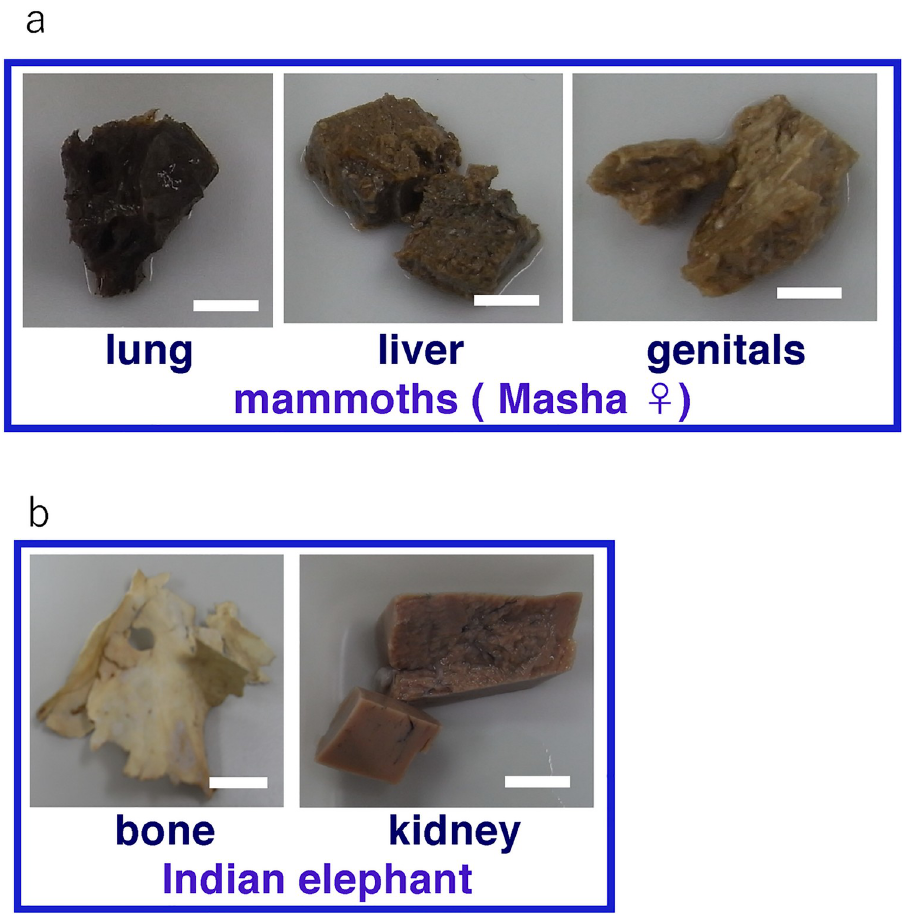
Fig 1. Sample pieces from mammoth and elephant tissues. (a) Sample pieces of lung, liver and genitals from baby mammoth (Masha) that were preserved in ethanol solution. Scale bar is 1 cm. (b) Sample pieces of bone and kidney from Indian elephant. Scale bar is